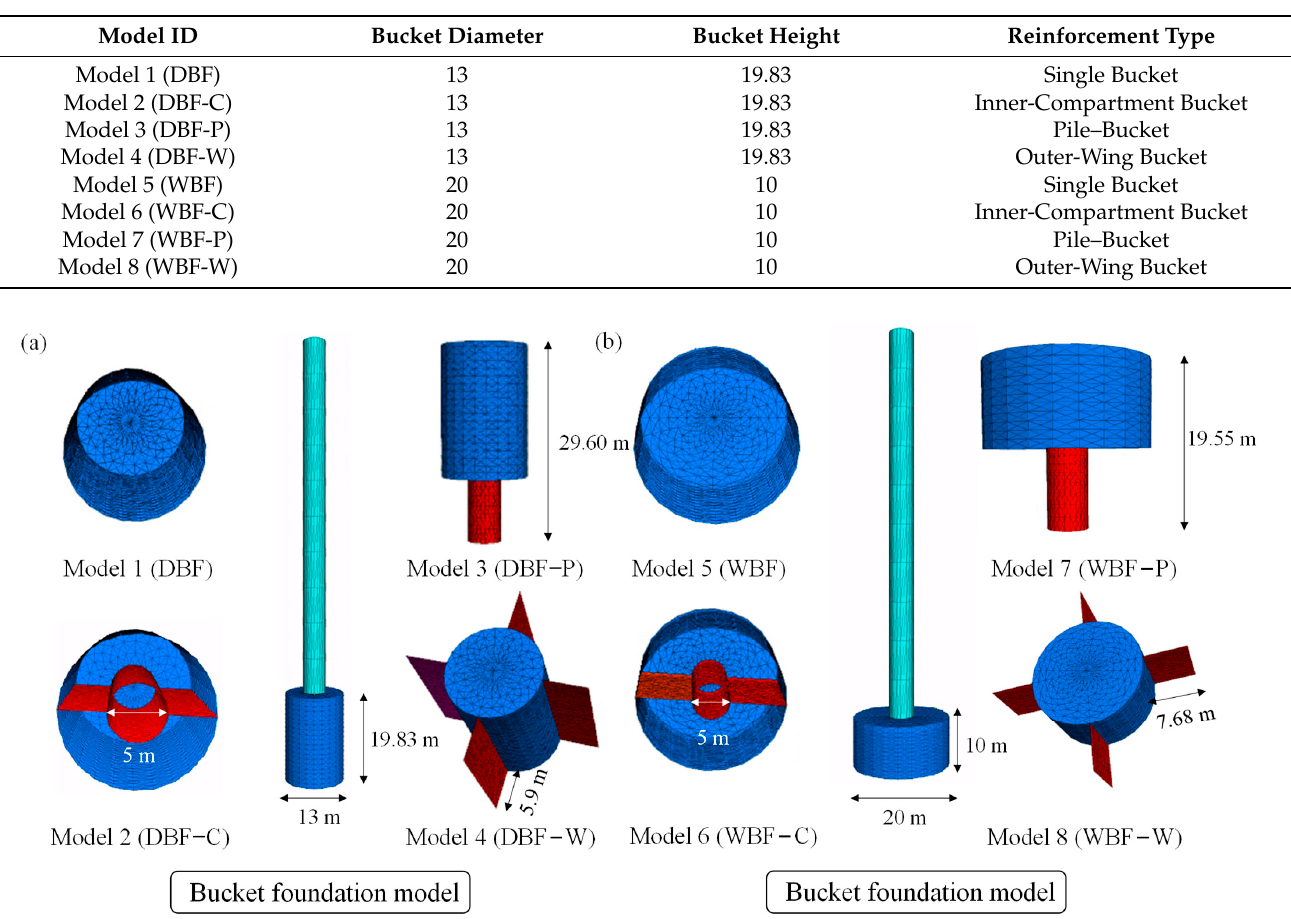
Table 1. Geometry and reinforcement type for the bucket foundation models.